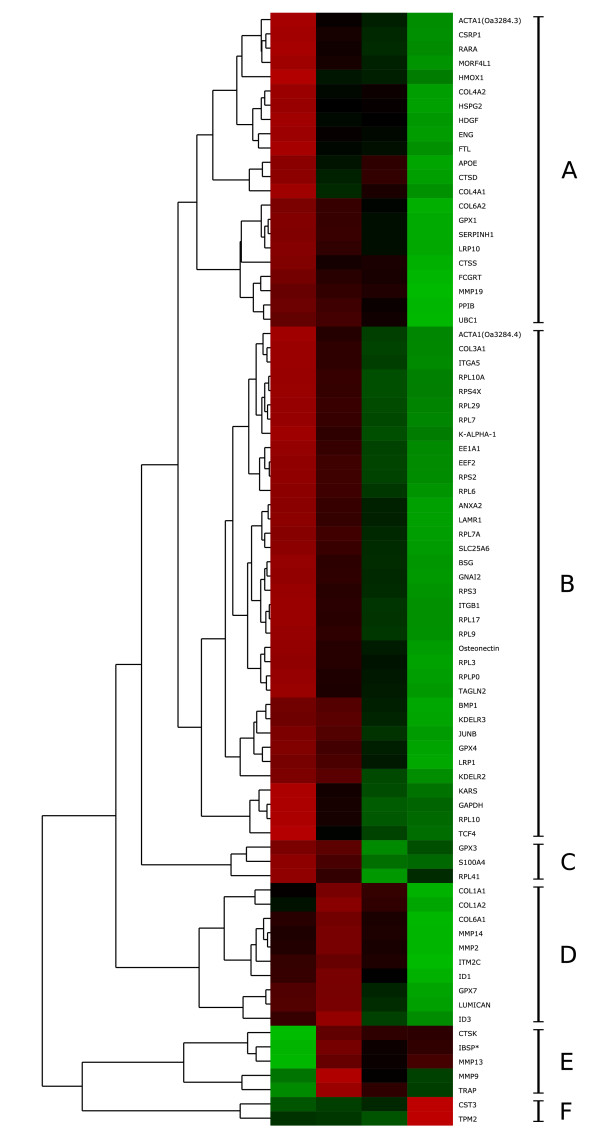
Cluster analysis of RT-PCR expression values. A dendogram showing expression profiles of the genes investigated by RT-PCR. For each of the 78 genes investigated by RT-PCR, expression values for 10d, 14d, and 42d were normalized to those at day 7 and clustered hierarchically by complete linkage (Values for IBSP were normalized to expression at day 10 because there was no detectable expression at day 7). The number of clusters was estimated by analysis with the gap-statistic (see Fig. 6). Six clusters A-F are shown.